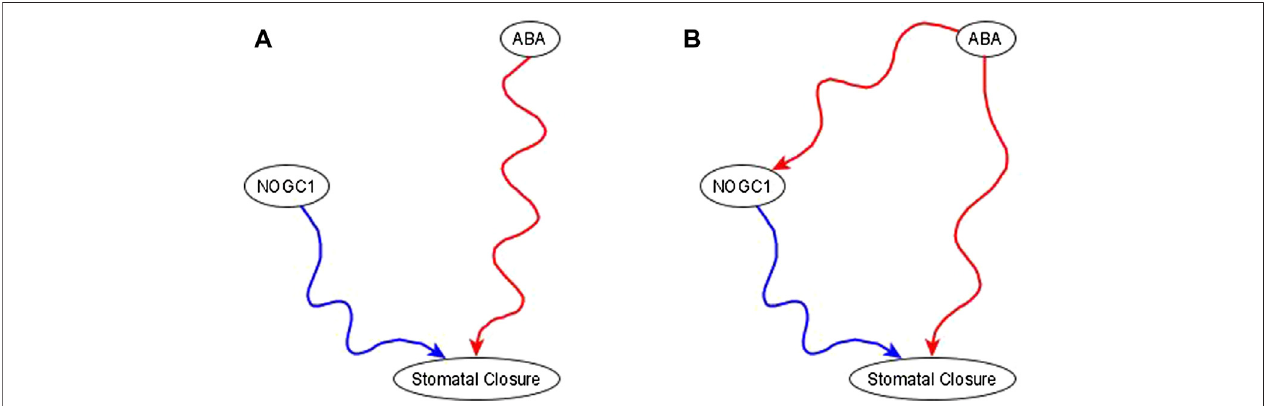
FIGURE 5 | Use of co-pointing subgraph inference method in the ABA signaling network. The signal, and source node of the network, ABA, is well-known to be suf fi cient for the target node stomatal closure and Nitric Oxide dependent Guanylate Cyclase (NOGC1) isa putative mediator ofthe signaling process. (A) . Experimental results show that NOGC1 knockout leads to a higher stomatal aperture, i.e., NOGC1 KO prevents the closing of the stomata, implying that NOGC1 is necessary for closure. (B) As per the co-pointing subgraph theorem, ABA must be suf fi cient for NOGC1. In a previously reported Boolean model of ABA induced closure (Albert et al., 2017), there is indeed a suf fi cient relationship from ABA to